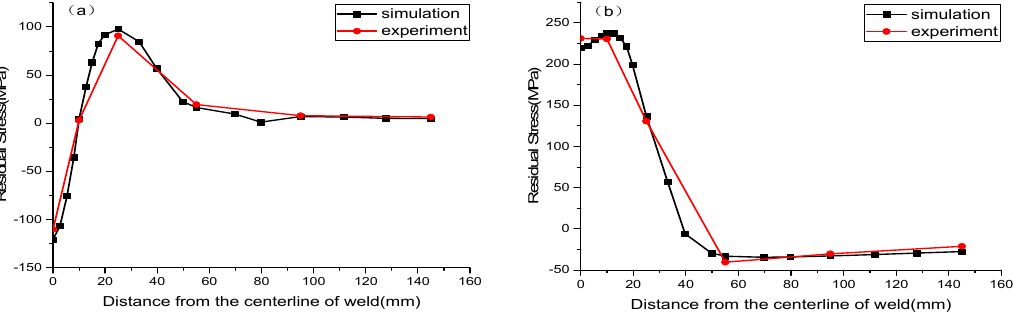
Figure 10. Colored map of the von Mises stress in simulation. The values on the left represent von Mises effective stress, where different colors indicate different stress values, and route 1 (black line) was chosen to compare the principal stress between simulation and experiment.